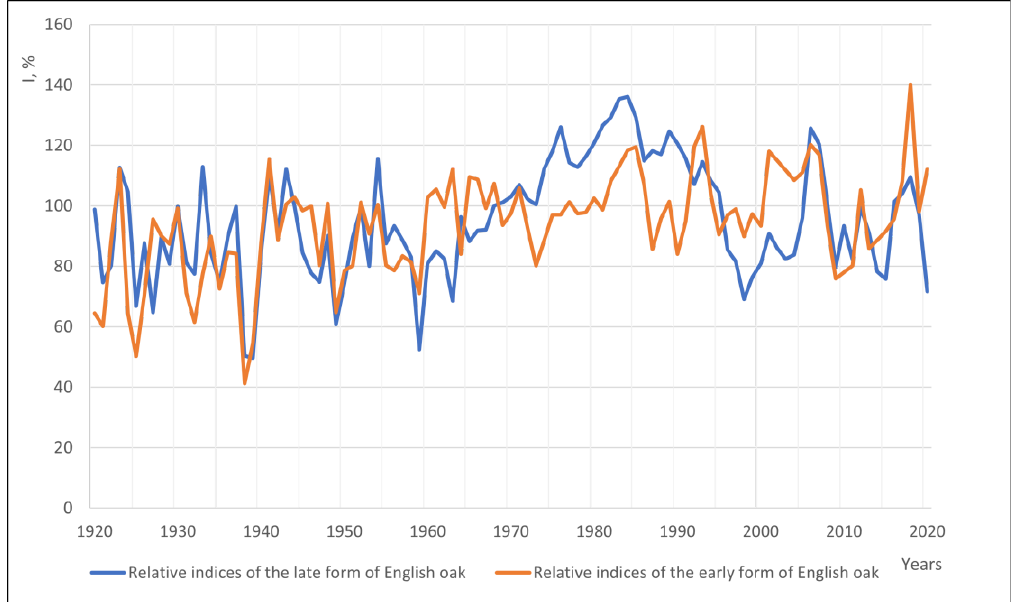
Figure 3. The dynamics of the relative indices of early and late wood in the wet goutweed oak stand.